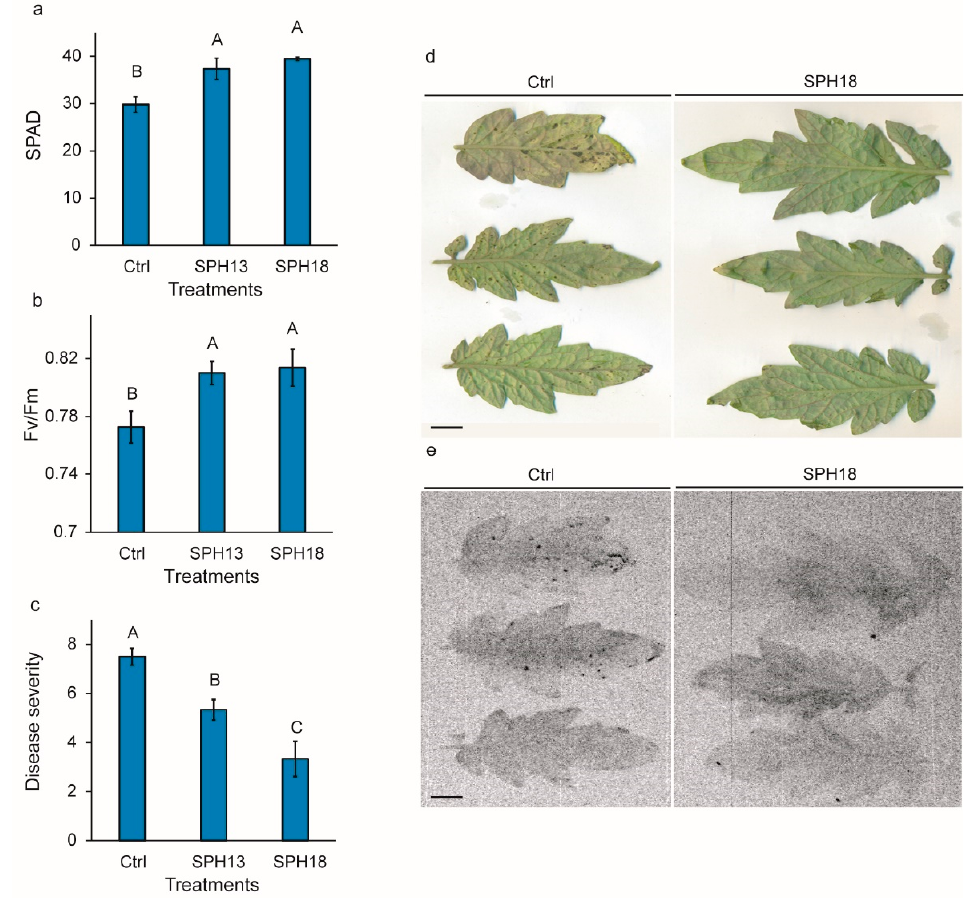
Figure 5. ( a – c ) Impact of the SPH drench application on M82 tomato plant resistance to Pseudomonas syringae pv. tomato DC3000-LUX ( Pst-LUX ). Plants were inoculated with Pst-LUX 3 days after treat- ments with water (Ctrl), SPH13 or SPH18 at 10 g L − 1 . Measurements were taken six days later. ( a ) SPAD index and ( b ) Fv/Fm measurements on the fourth leaf taken from the bottom of the plants ( n = 6). ( c ) The number of necrotic spots was counted on each plant and reported on a predefined disease severity scale: 1 = 1–10 lesions, 2 = 11–25 lesions, 3 = 26–50 lesions, 4 = 51–75 lesions, 5 = 76– 100 lesions, 6 = 101–150 lesions, 7 = 151–200 lesions and 8 = over 200 lesions ( n = 6, one-way ANOVA with post hoc LSD, p < 0.05, means with the same letter are not significantly different). ( d ) Scans of 3 randomly selected leaflets taken from plants treated with water (Ctrl) or SPH18 at 10 g L − 1 . ( e ) Bioluminescence imaging of the same leaflets ( n = 3). ( a – e ) Tomato seeds were sown on 7 March 2022.